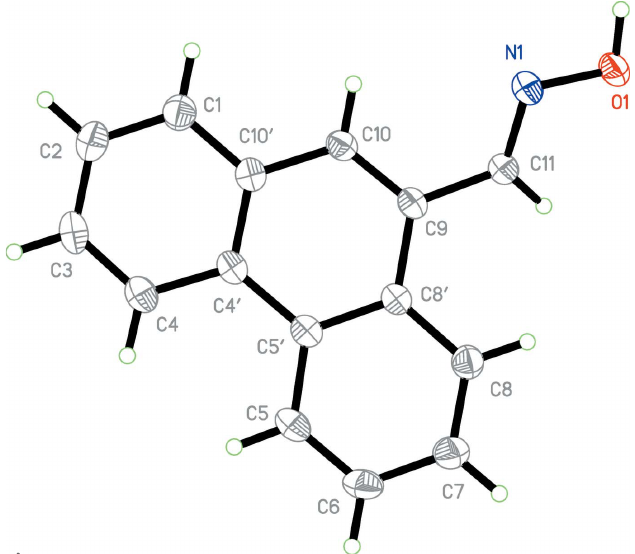
Figure 2 The molecular conformation and atom-numbering scheme for (II), with non-H atoms represented as 30% probability ellipsoids.